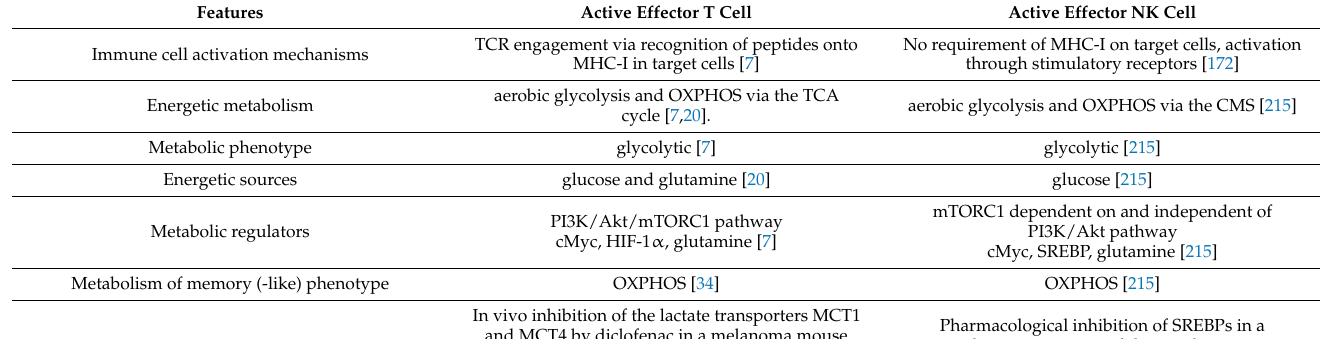
Table 1. Comparison between T and NK cell recognition mechanisms, metabolic features, approaches to improve effectivity of adoptive cell transfer, CAR designs boosting their metabolism and strategies to improve metabolic fitness of CAR-expressing